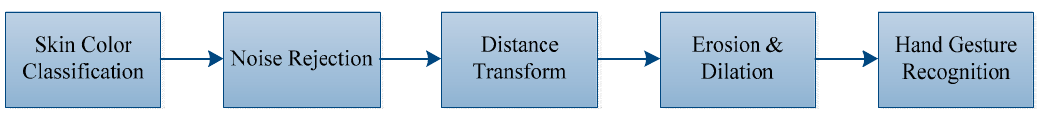
Figure 5. Gesture Recognition Process.